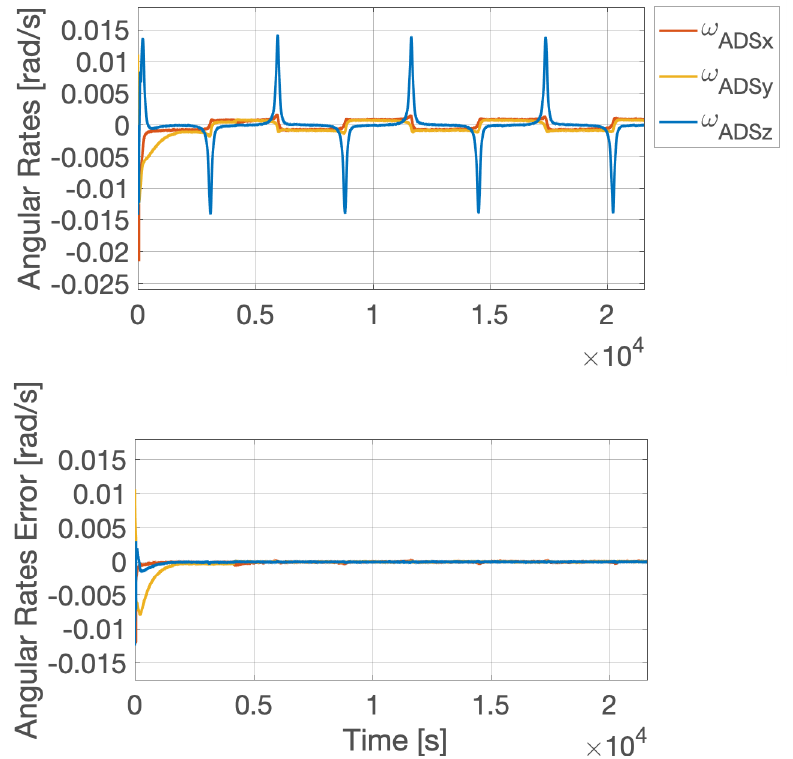
Figure 6. Angular rates error in MIL analysis of Earth pointing AODS, with continuous nadir rotation to align solar